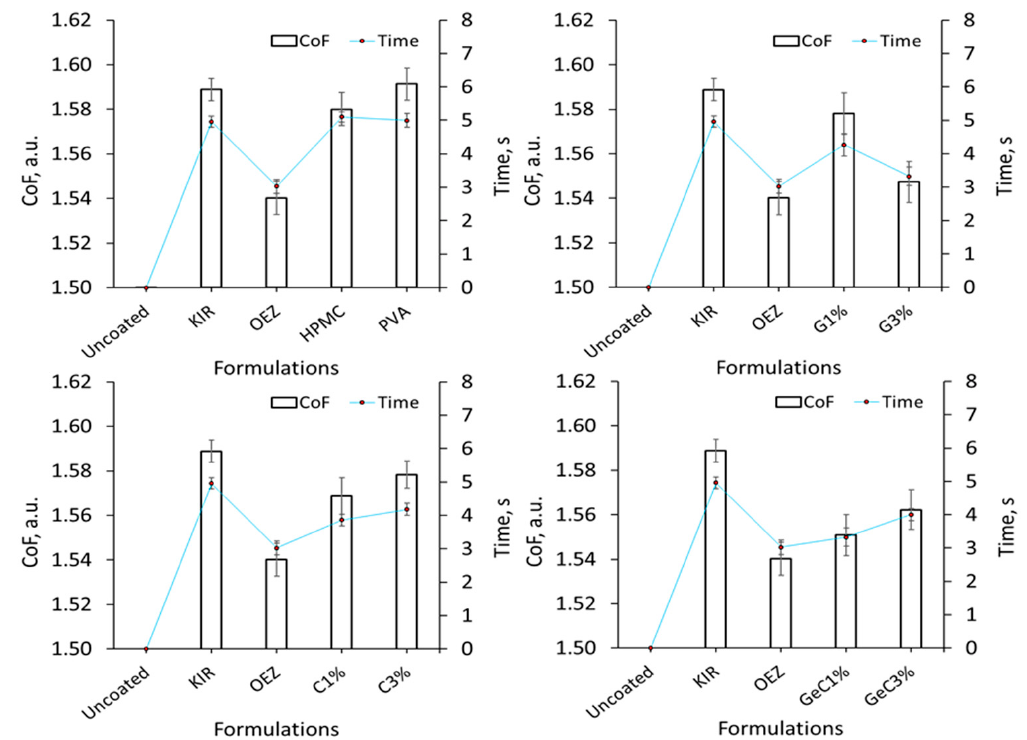
Figure 5. Determination of the sliding coefficient of friction (CoF) and mobility time of film-coated tablets with KIR as the control and fixed at 10% w / w . Coulomb’s friction model F F = μ F N was used to determine the CoF by using the weight to run its course on a 3D SLA printed in vitro oral apparatus, and it can be seen that the binary and/or ternary addition of λ -carrageenan and/or gelatin in combination effectively reduced the in vitro friction forces exhibited by the control KIR. OEZ yielded the lowest resistance to tangential motion, exhibiting a relatively superior wet-slip profile than any film coating system (ANOVA, p < 0.05).